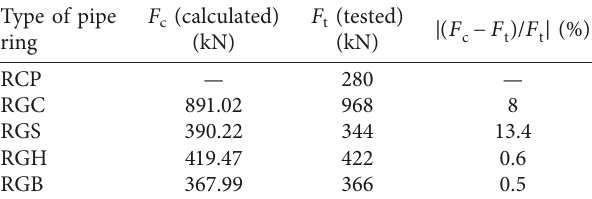
Table 2: Calculation results of the load-carrying capacity. Type of